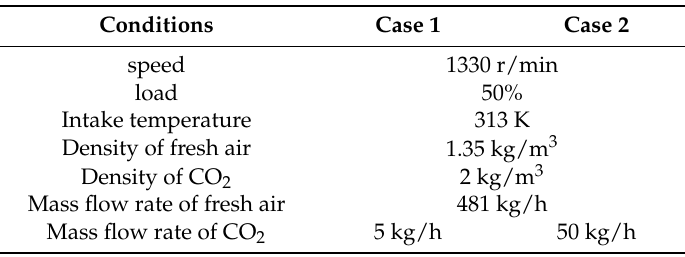
Table 2. Simulation